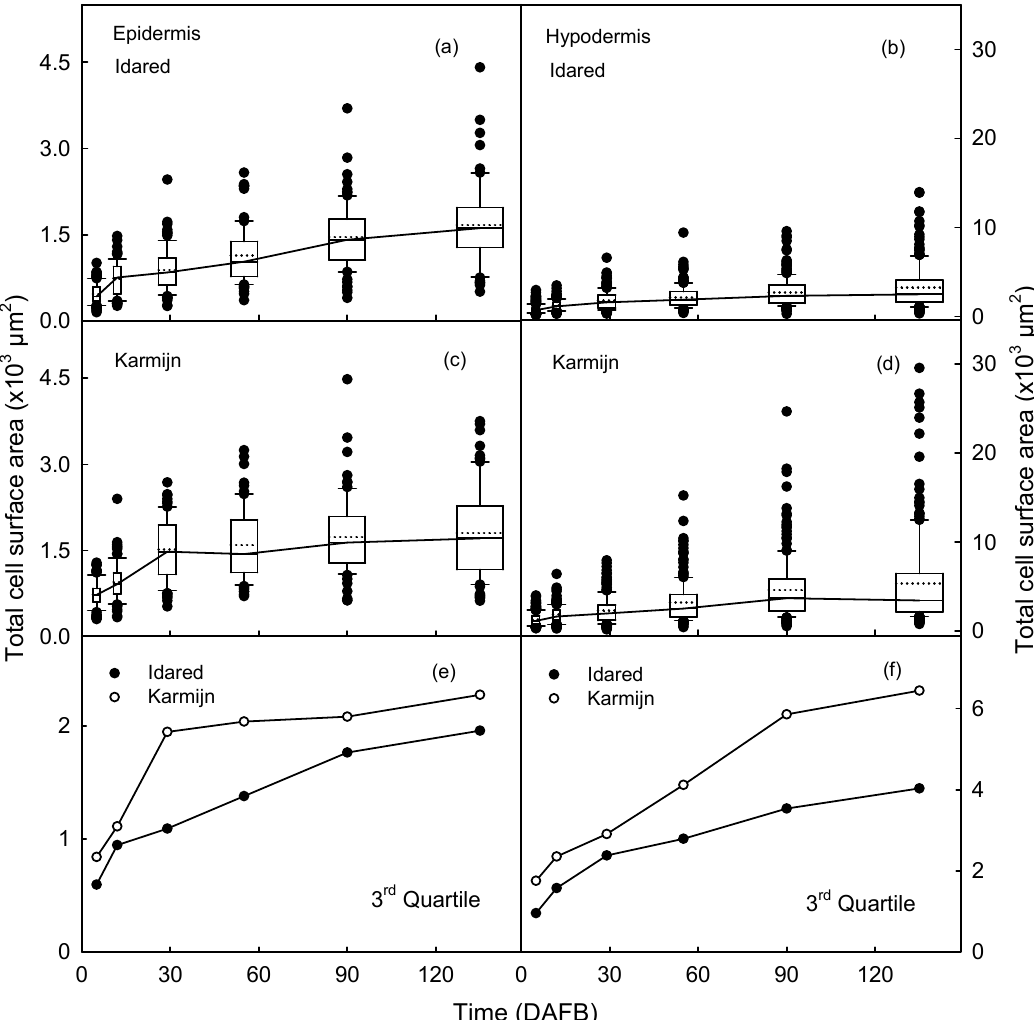
Figure 4. Boxplots of total surface area of epidermal ( a , c ) and hypodermal ( b , d ) cells at various stages of fruit development of ‘Idared’ ( a , b ) and ‘Karmijn’ ( c , d ) apples. The 3rd quartile values of the total surface area of epidermal ( e ) and hypodermal ( f ) cells. The numbers of replicates were 68–100 (epidermis) and 179–228 (hypodermis) cells. Cells were measured in seven fruit.